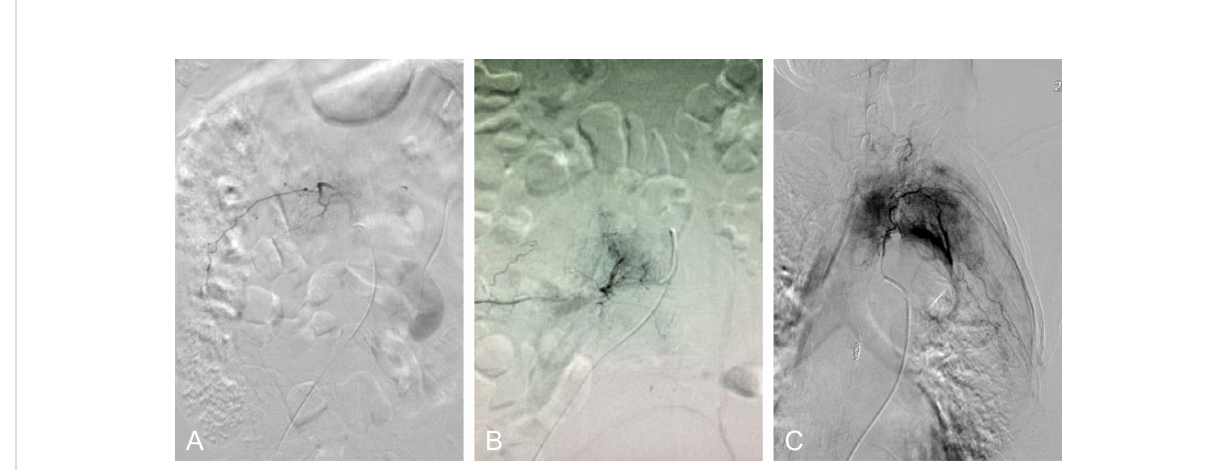
FIGURE 2 The evaluation of hypervascularity. (A) Mild hypervascularity; (B) Moderate hypervascularity; (C) Severe hypervascularity.